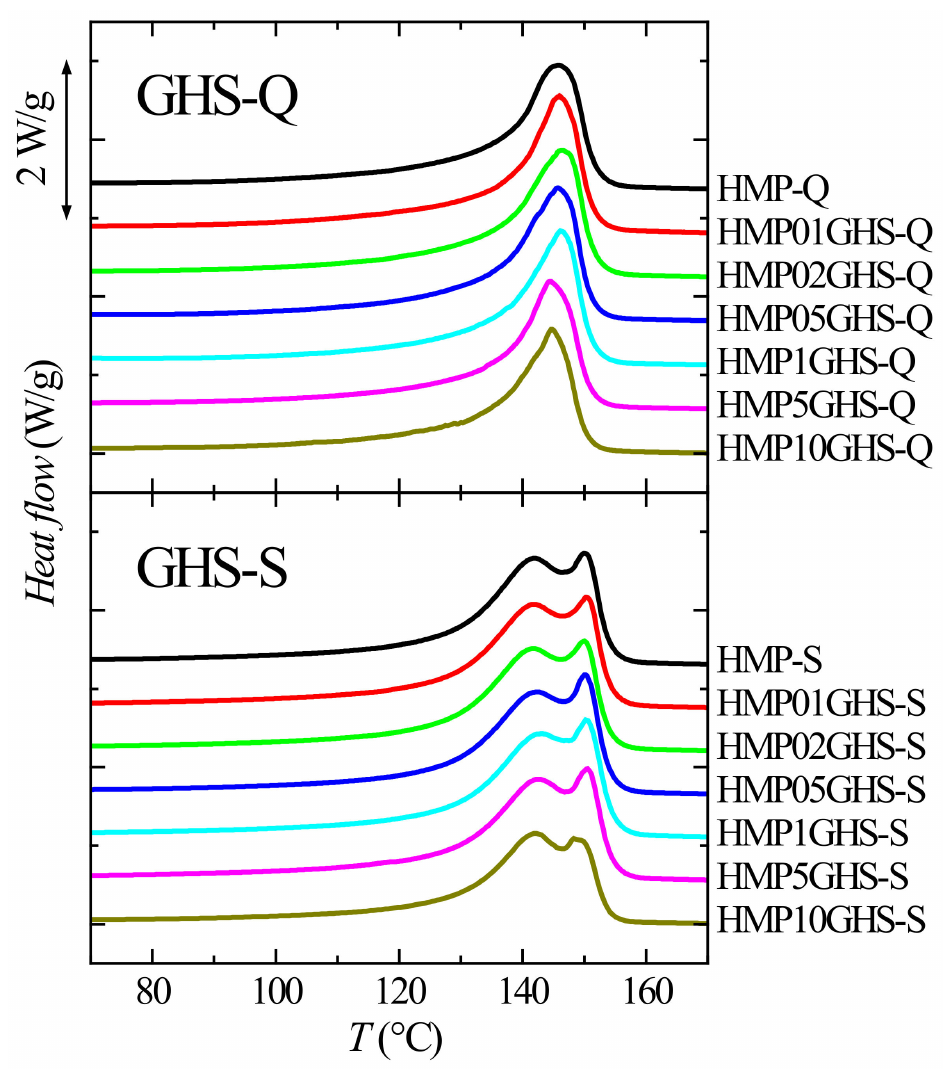
Figure 6. DSC first melting curves for the neat HMP and the GHS nanocomposites at the two thermal treatments applied: Q ( top plot) and S ( bottom